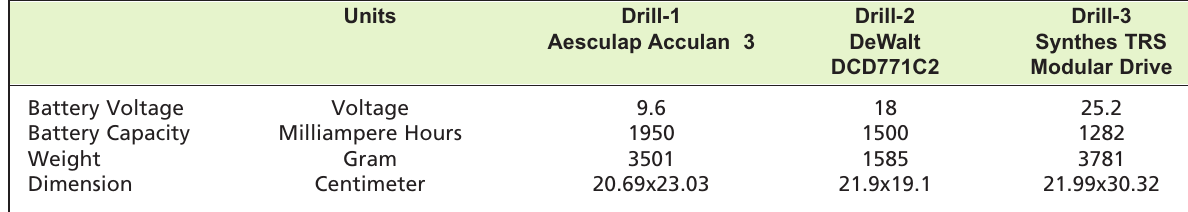
Battery voltage, battery capacity, weight and dimension features of drills. Table II: